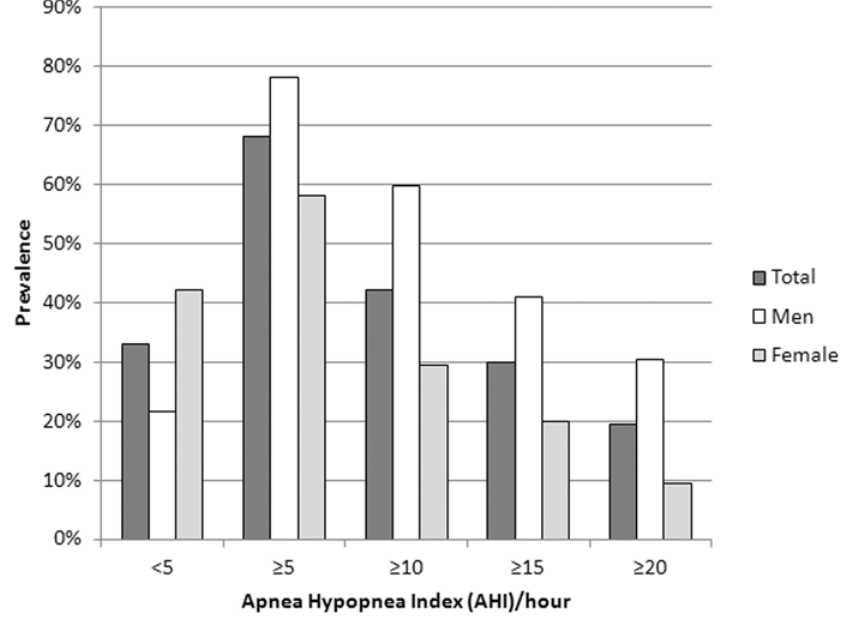
Fig 3. OSAS prevalence illustrated upon gender according to apnea hypopnea index (AHI) quartile.